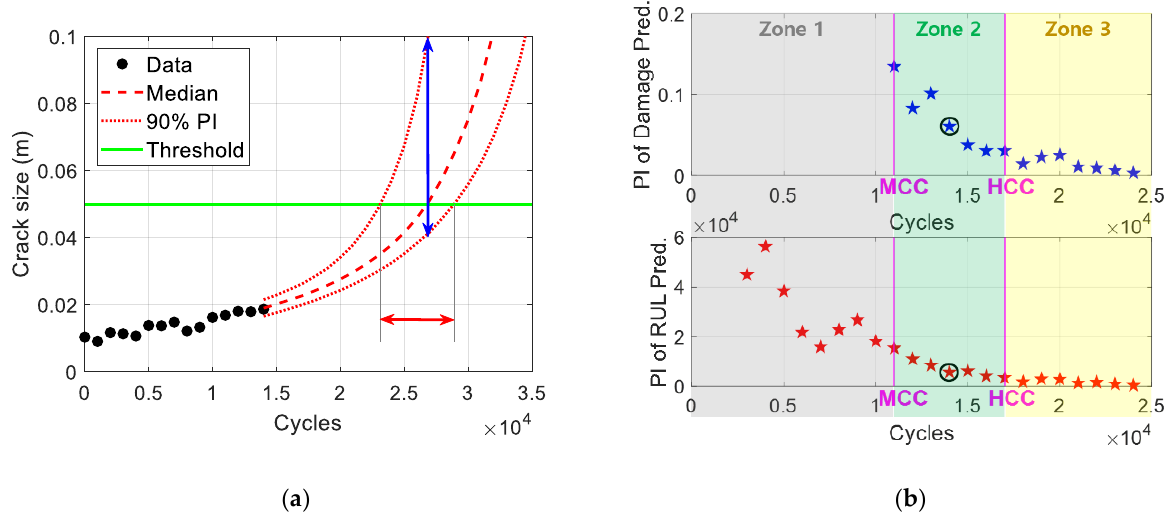
Figure 5. PI-based credibility criteria. ( a ) Illustration of the two types of PI, ( b ) PIs and credibility criteria.